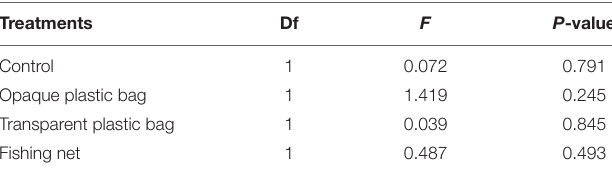
TABLE 1 | Statistical analysis of dissolved oxygen above and below marine debris in each treatment tank.